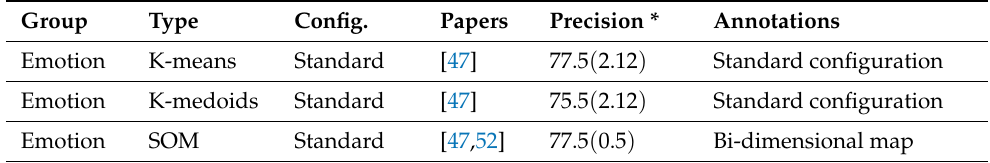
Table 18. Unsupervised learning methods for emotion classification. Group Type Config. Papers Precision * Annotations Emotion K-means Standard [47] 77.5 ( 2.12 ) Standard configuration Emotion K-medoids Standard [47] 75.5 ( 2.12 ) Standard configuration Emotion SOM Standard [47,52] 77.5 ( 0.5 ) Bi-dimensional